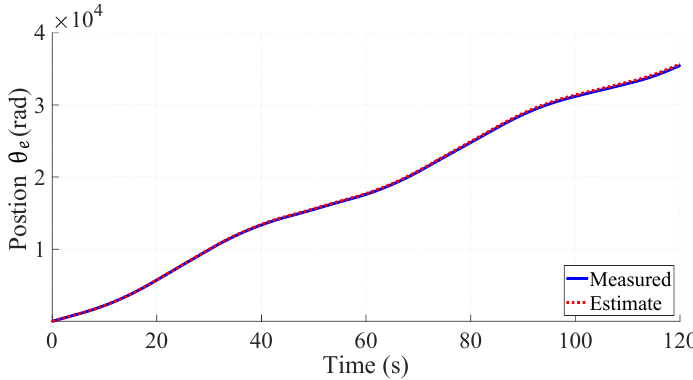
Figure 11. Comparing estimated θ e with measured θ e .